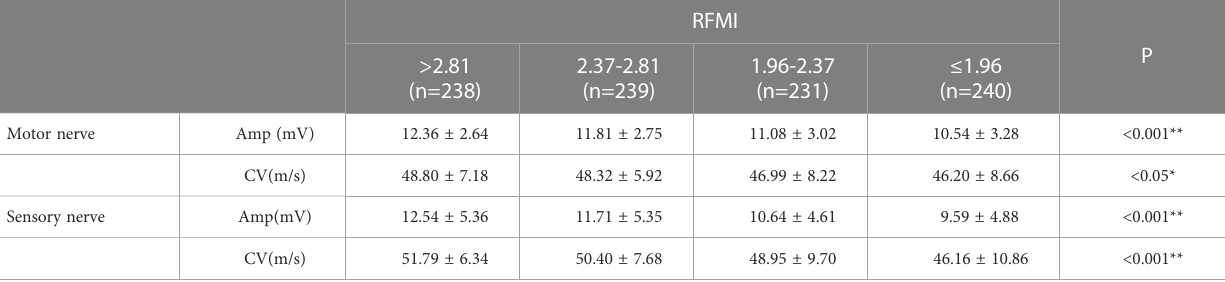
TABLE 3 Nerve conduction of T2DM patients strati fi ed by RFMI